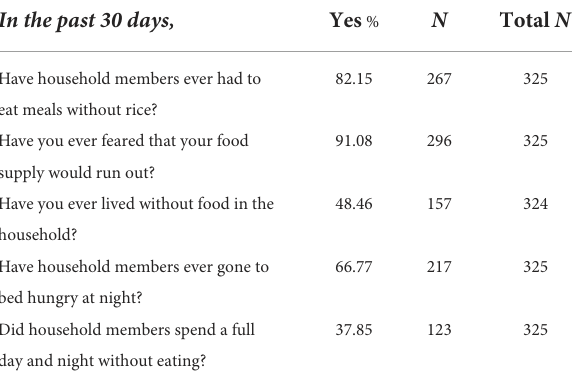
TABLE 3 Response rates to food insecurity questions making up the five-item food insecurity scale.